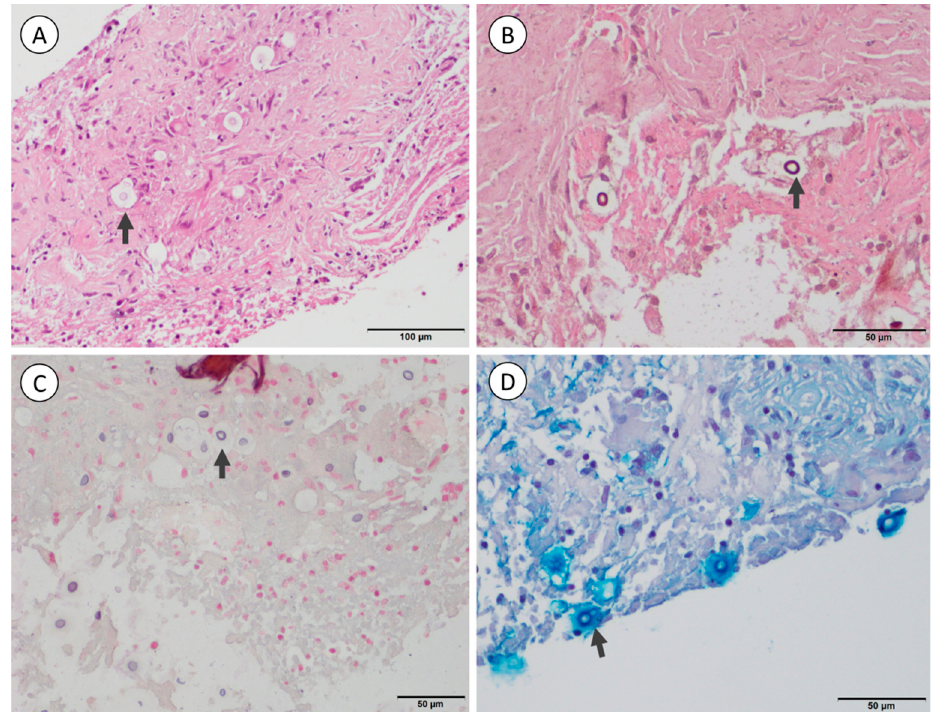
Figure 2. Biopsy of the third ventricle wall showing numerous spherical to oval yeast-like cells (arrows) embedded in a granulomatous reaction with some giant cells. The mucopolysaccharide capsule forms a clear halo around the fungal cells in Hematoxylin and eosin ( A ), Grocott-Gomori’s ( B ), and Fontana-Masson stains ( C ), while with Alcian blue stain ( D ), it is deeply colored.